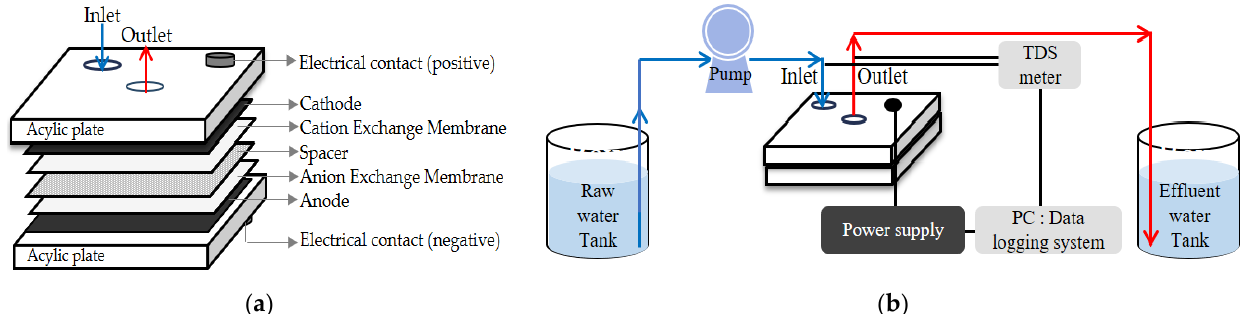
Figure 2. ( a ) Configuration of the lab-scale MCDI module unit cell; ( b ) schematic diagram of the lab-scale experimental setup for CDI process. Table 1. Summary of MCDI module specification.